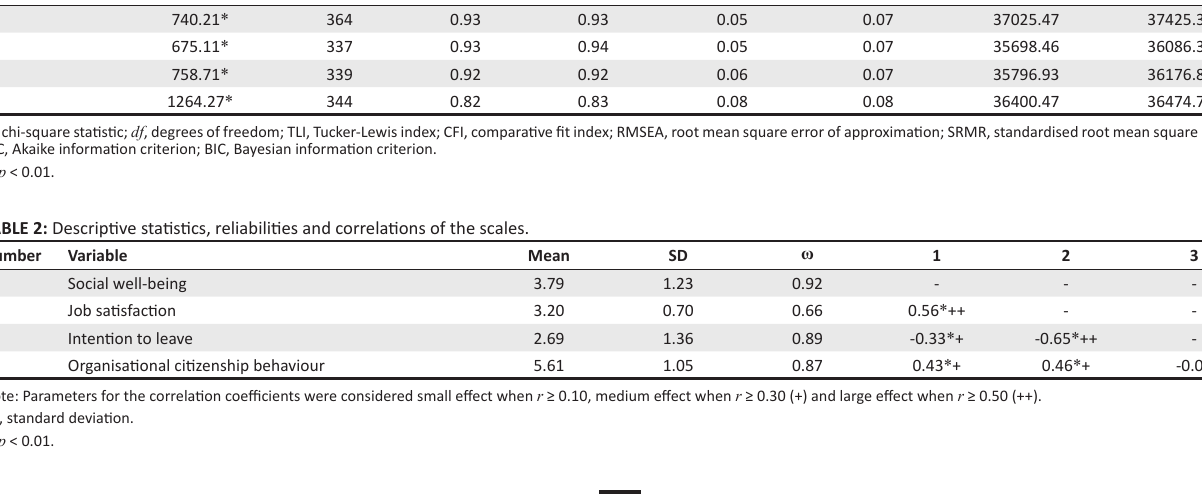
TABLE 1: Fit statistics for the competing measurement models. Model